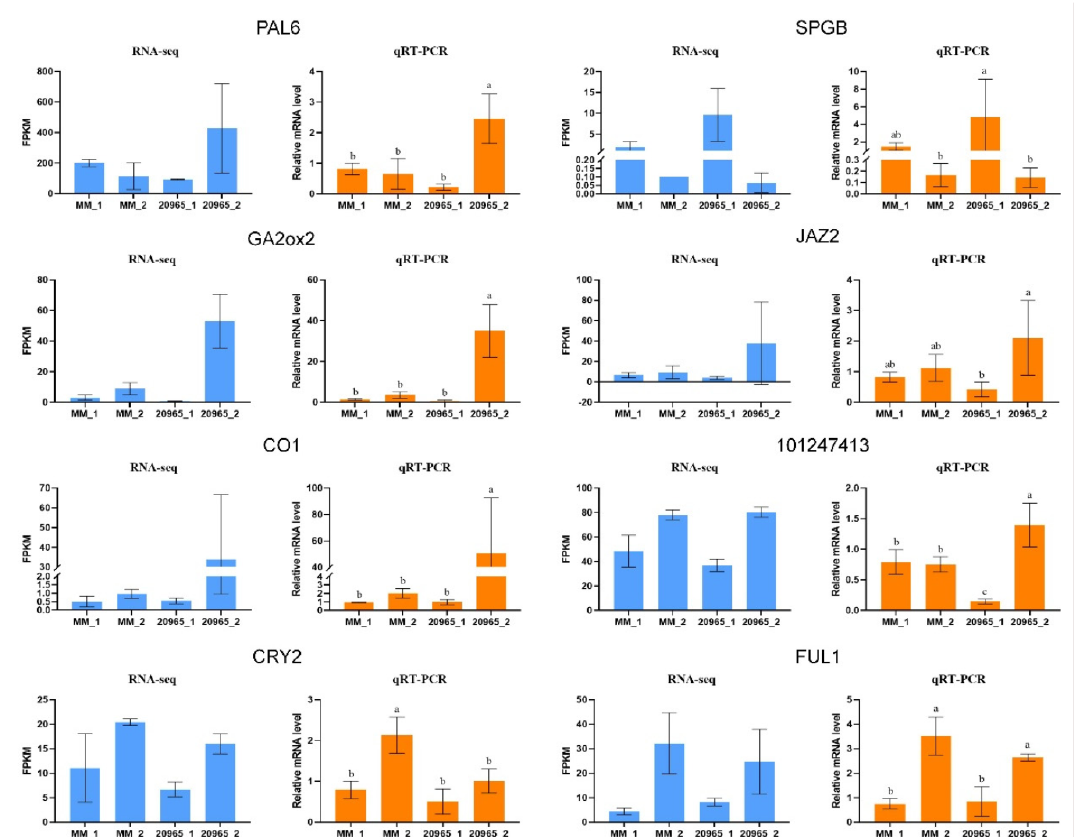
Figure 8. FPKM values obtained via RNA-seq and relative mRNA levels obtained via qRT-PCR for 8 DEGs. Three technical replicates were performed for each biological replicate of each sample. Error bars represent standard deviation. p < 0.05 means significant difference: a was significantly higher than b and c; b was significantly higher than c. There was no significant difference between the same